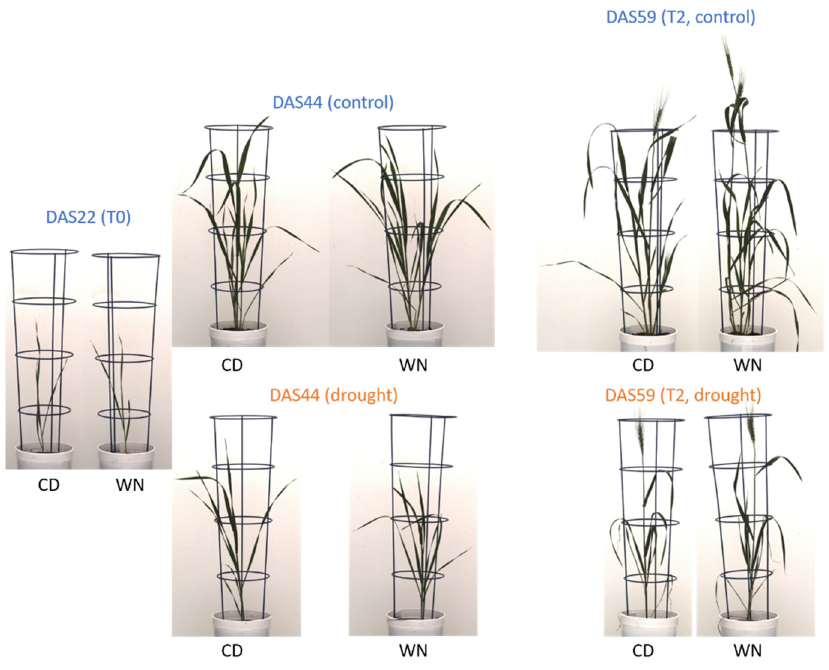
Figure 8. Individual plant images from RGB side view camera for plant at harvesting times T0 (DAS 22), DAS 44, and T2 (DAS 59) from Condor (CD) and Wadielniel (WN). Using these photography’s RGB side view images, we determined the day of heading (BBCH 55, half of the ear is out of the flag leaf) [17], the number of tillers, as well as the number of ears at DAS 71, 85, and 98. The number of tiller was counted manually before and during drought stress at DAS 22 (T0), 44 and 53. After flowering, the number of ears was determined by visual inspection of RGB side view images at DAS 71, 85, and 98. At maturity, we determined plant height excluding awns, the length of ear and awns (of the main ear) the length of peduncle, and the length of the last internode. We determined the weight of total above ground biomass, then threshed the plant and evaluated the grain weight, then calculated the harvest index and the straw weight. Further, we determined the total number of seeds (whole plant and main ear) and using the Seed Analyzer “Marvin” (GTA Sensorik GmbH, Neubrandenburg, Germany), we measured the Thousand kernel weight (TKW), average seed area, length, and width. The number of spikelets of the main ear were also counted and we calculated the number of seeds per spikelet.